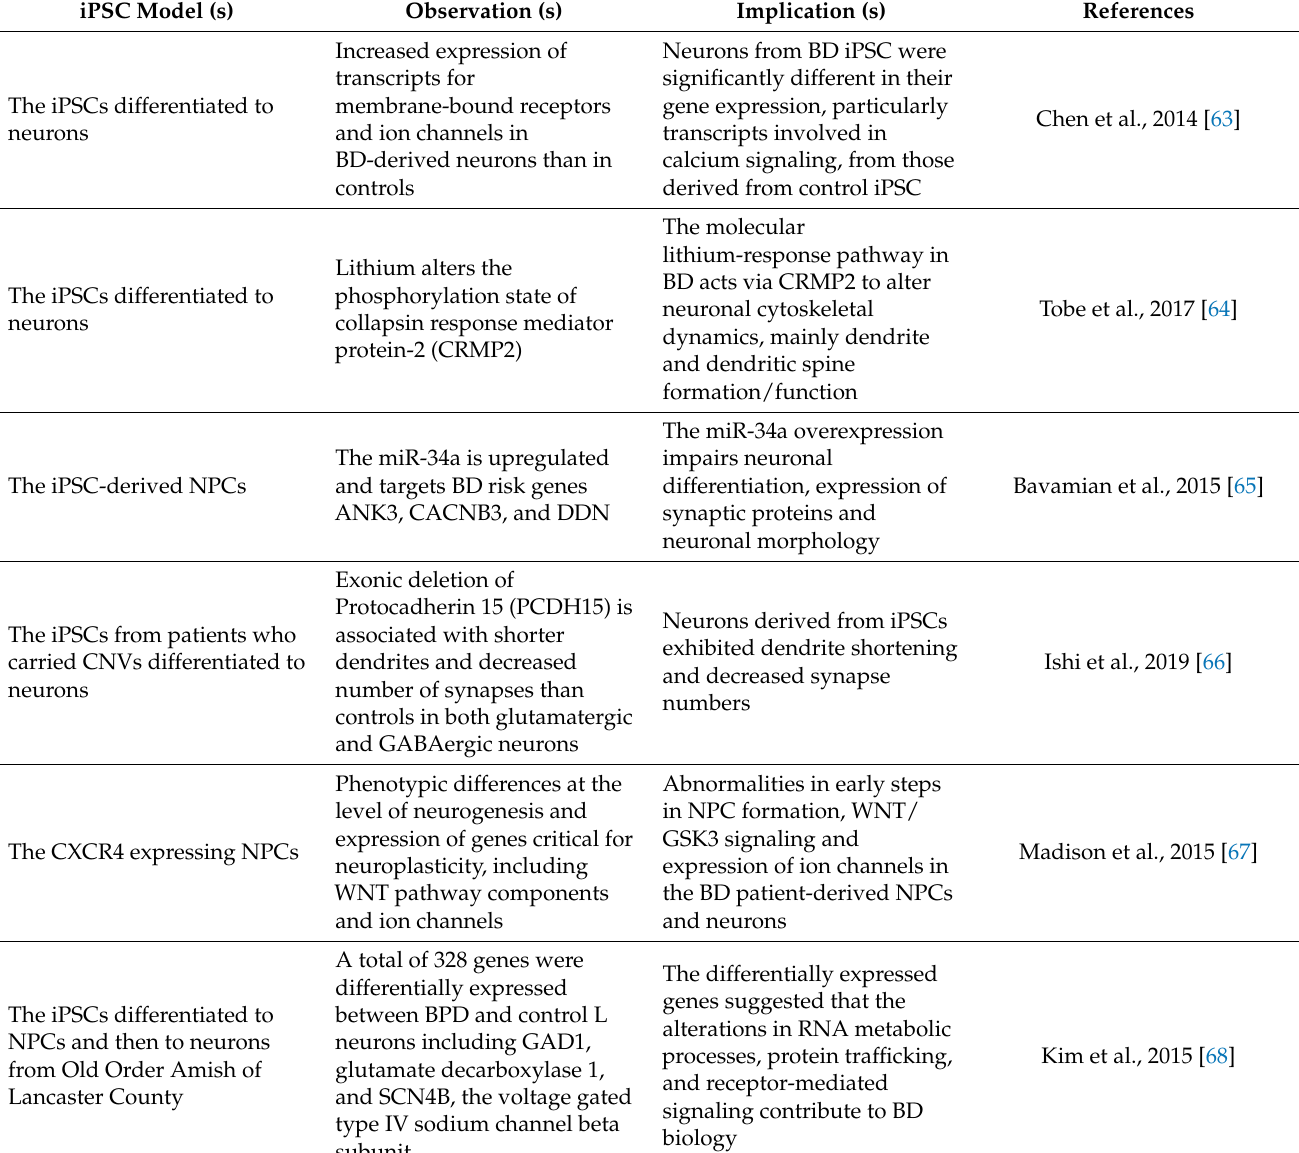
Table 3. Selected studies investigating bipolar disorder using iPSCs from